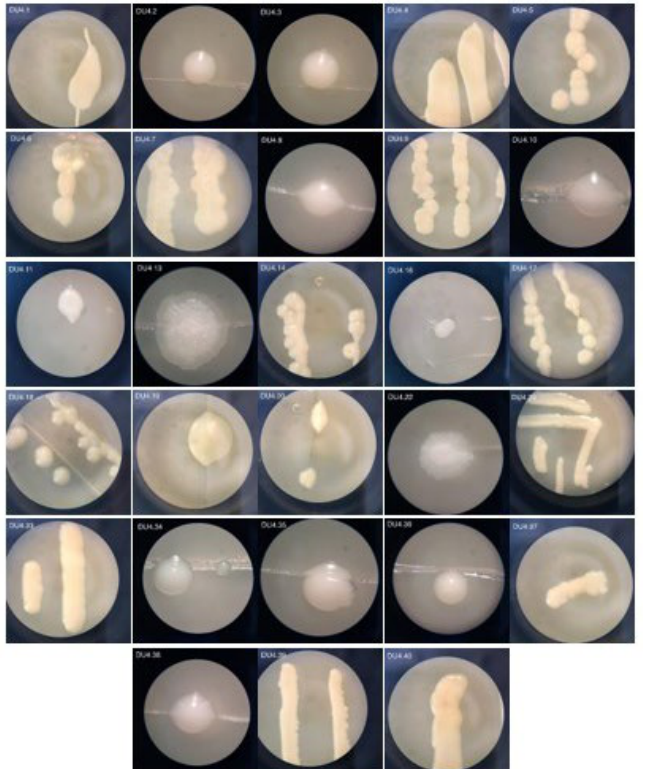
Fig. 3. Morphological characteristic of yeast isolated from Lai durian with code DU4, incubated on YMA medium at 28°C for 24 table 1. Yeasts isolated from Lai durian DU4 on YMA medium, incubated at 28°C for 48h. 40 isolates were obtained with various morphological characteristics Sample Number of Colony